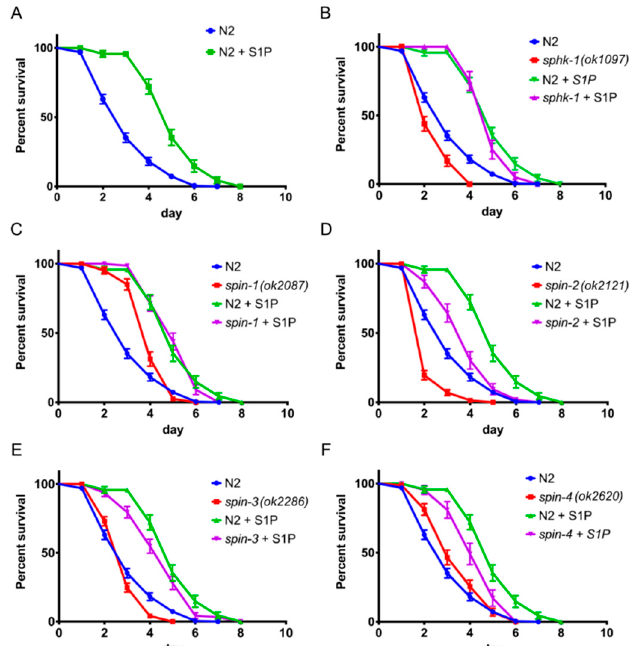
Figure 3. External supplementation of S1P stimulates the immune response to P. aeruginosa PA14 in C. elegans. The survival of worms with or without S1P supplementation in the background of wild type N2 worms ( A ), sphk-1 ( B ), spin-1 ( C ), spin-2 ( D ), spin-3 ( E ), and spin-4 ( F ). The log-rank (Mantel-Cox) test was used for statistical analysis of worm survival.